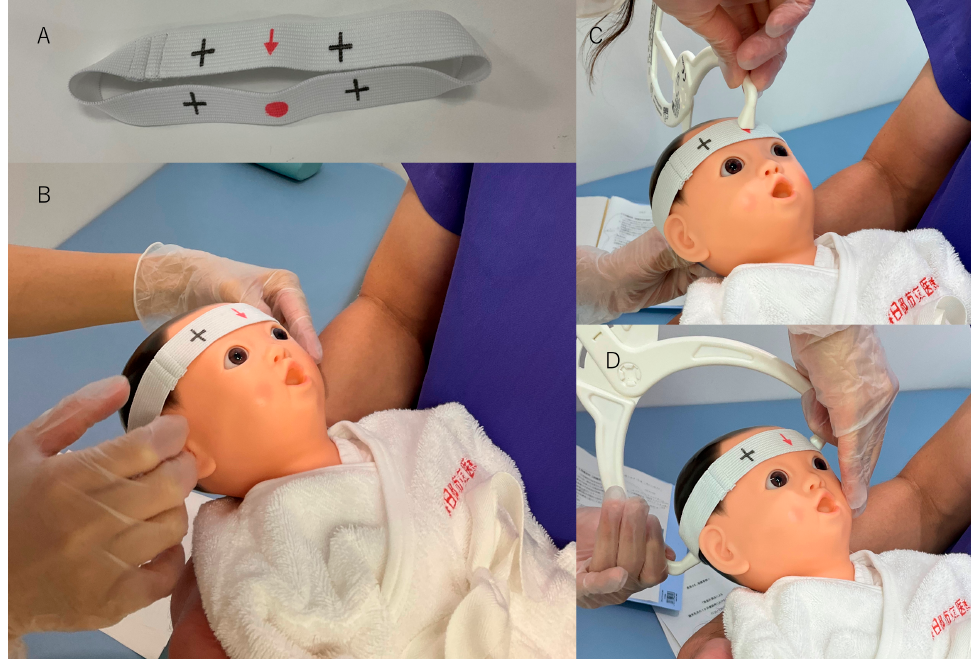
Figure 1. Procedure for measurement using calipers and elastic bands. ( A ) The elastic band included in the Mimos craniometer. ( B ) Elastic bands are placed with the “ ↓ ” symbol between the eyebrows and the “ ● ” symbol at the protuberantia occipitalis externa. ( C ) Cranial length is the length between “ ↓ ” and “ ● ” on the band. ( D ) The length of the longer diagonal of the “+” symbols measured diagonally is designated as diagonal A.